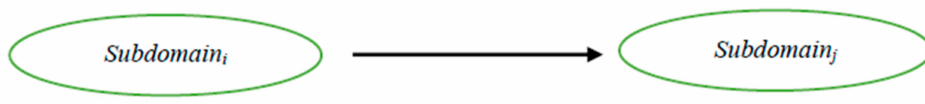
Figure 9. Causal relation in FBBN using the relation direction